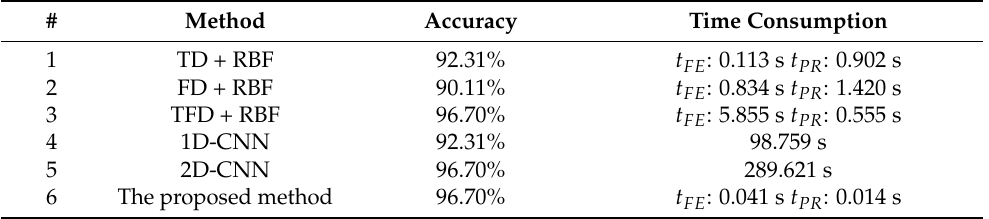
Table 7. Comparisons based on fault diagnosis of driving gear in BSS.